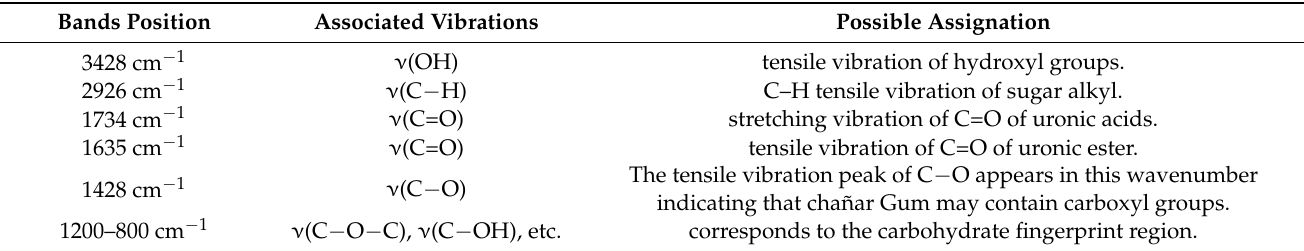
Table 2. Principal absorbance bands of FTIR spectra of CHT and CHA gums [46,58–63]. Bands Position Associated Vibrations Possible Assignation tensile vibration of hydroxyl groups. stretching vibration of C=O of uronic